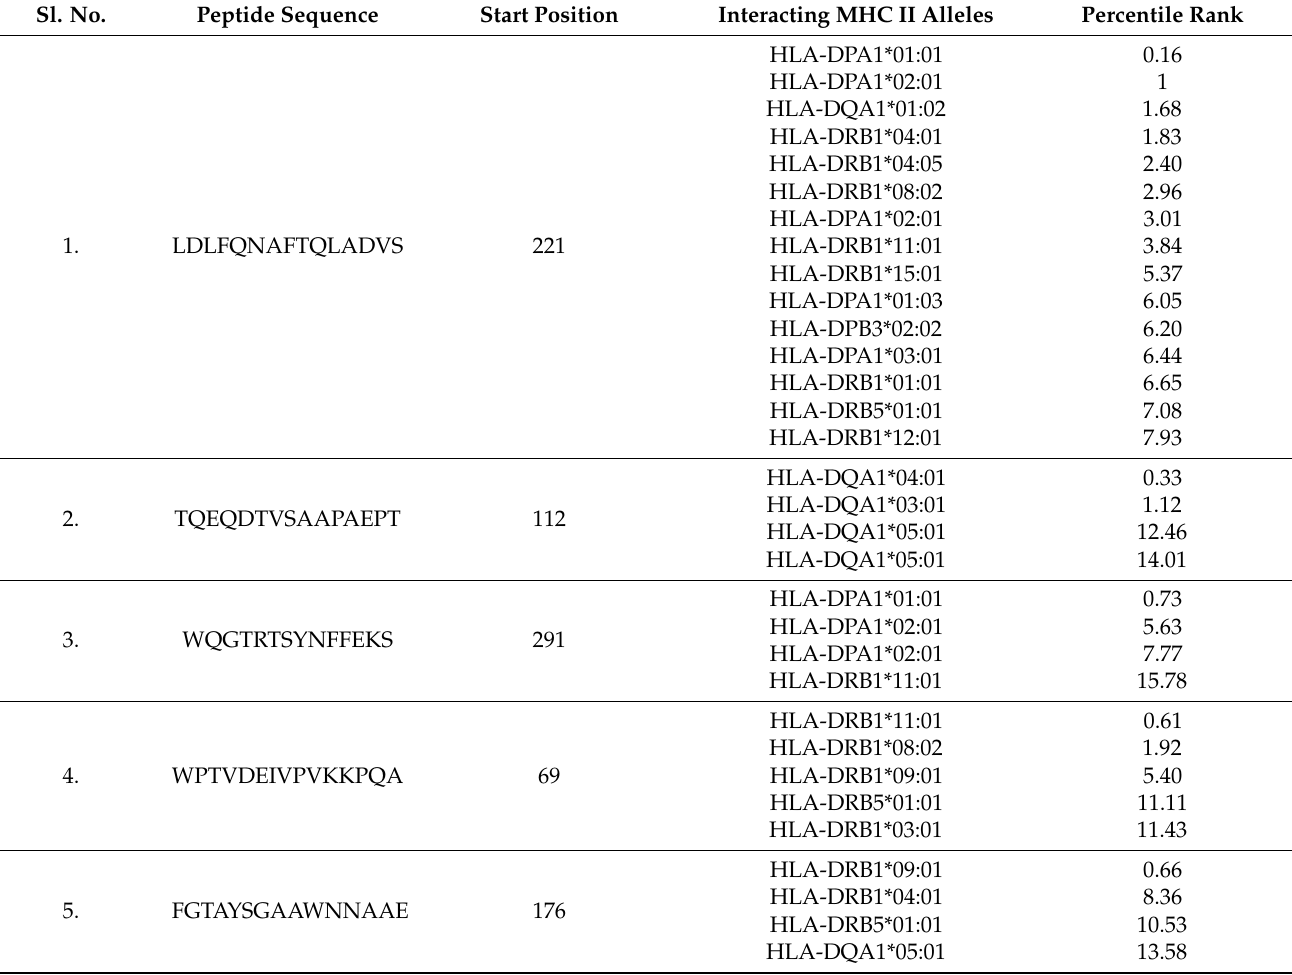
Table 6. Result for interacting MHC II super type